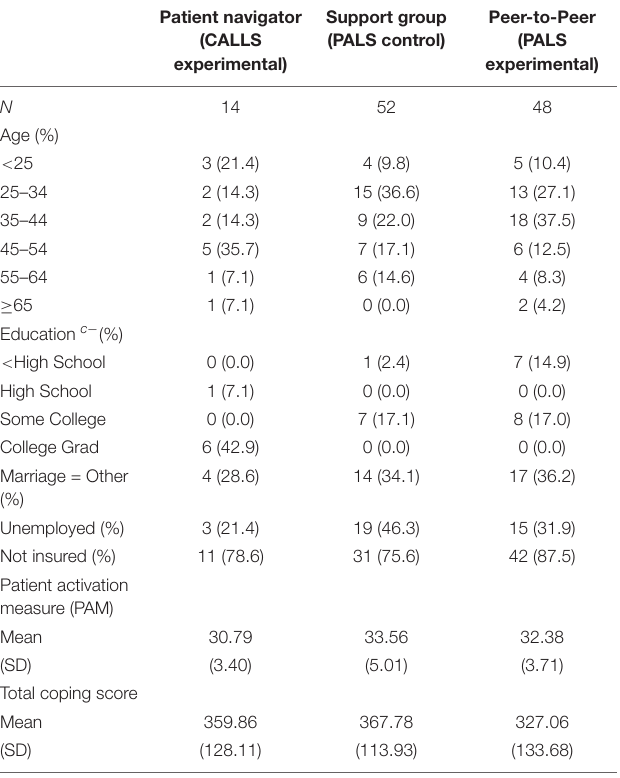
TABLE 1 | Demographic characteristics of participants in patient navigator, support group, and peer to peer intervention